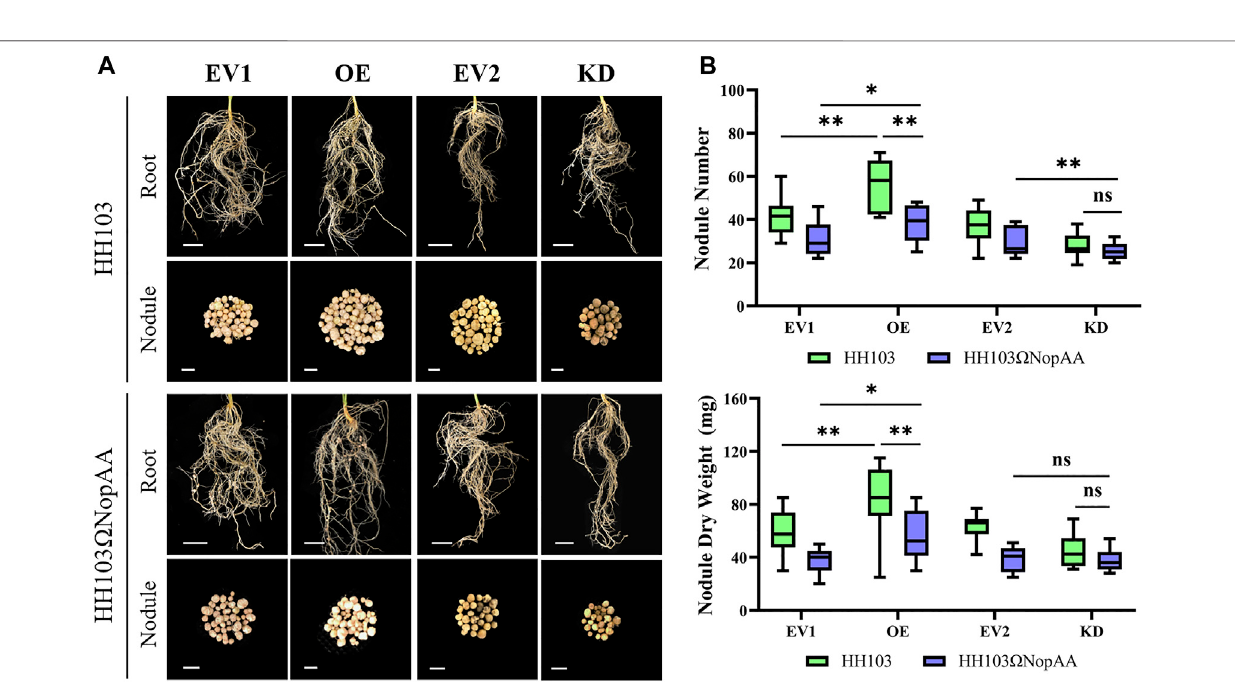
Frontiers in Genetics |